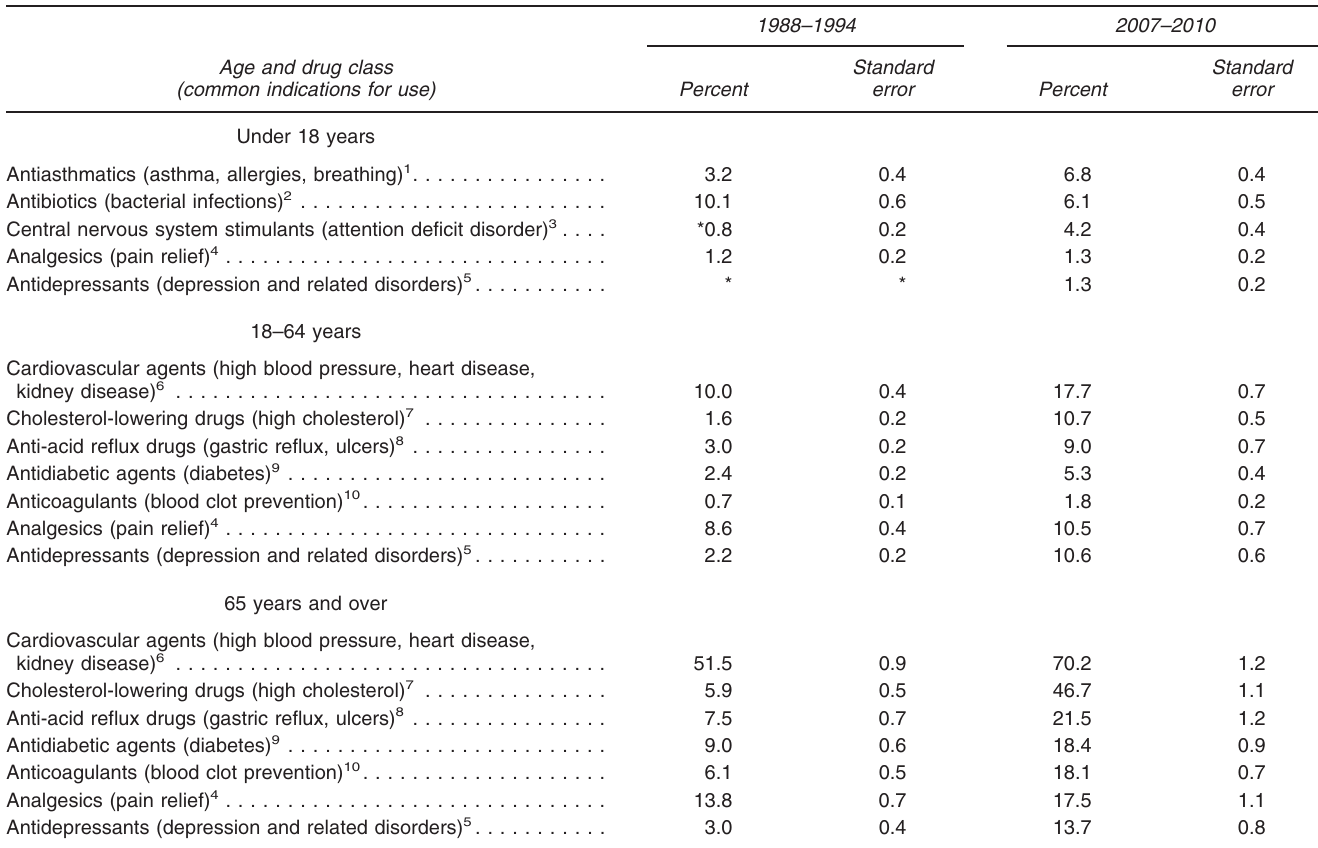
Data table for Figure 21. Prescription drug use in the past 30 days, by age and selected drug class: United States, 1988–1994 and 2007–2010 Excel and PowerPoint: http://www.cdc.gov/nchs/hus/contents2013.htm#fig21